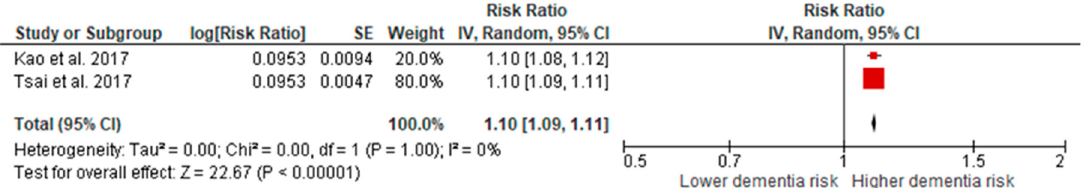
Figure 3. Risk of dementia in AKI patients with one year increase in age .